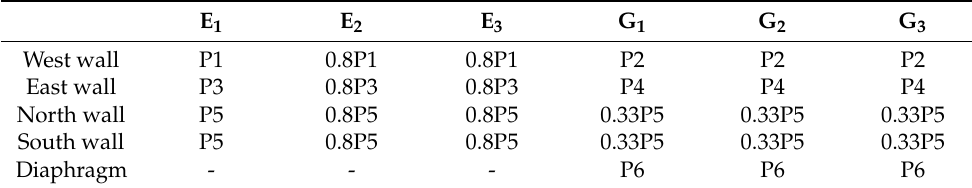
Table 1. The material parameters considered in the calibration